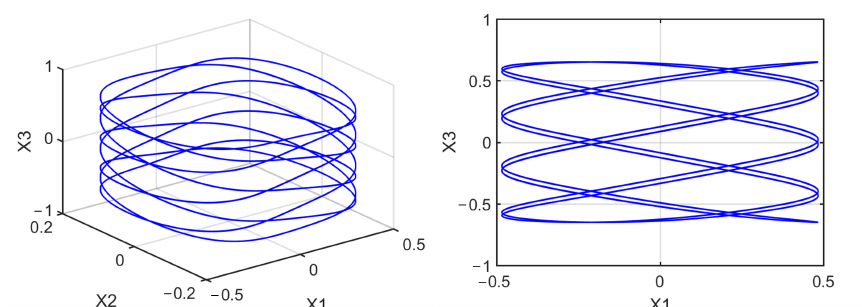
Figure A16. Periodic-8 motion of σ 1 = 9.6648.